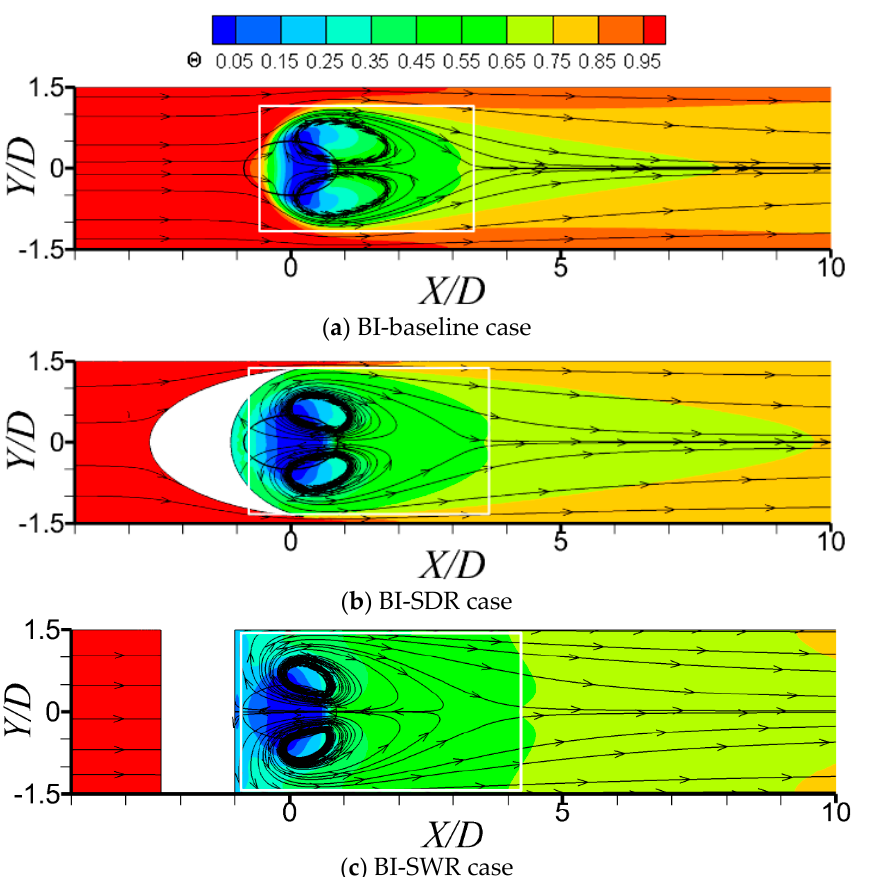
Figure 10. Dimensionless temperature contours and streamlines on horizontal plane of Z/D = 0.125 in BI cases.